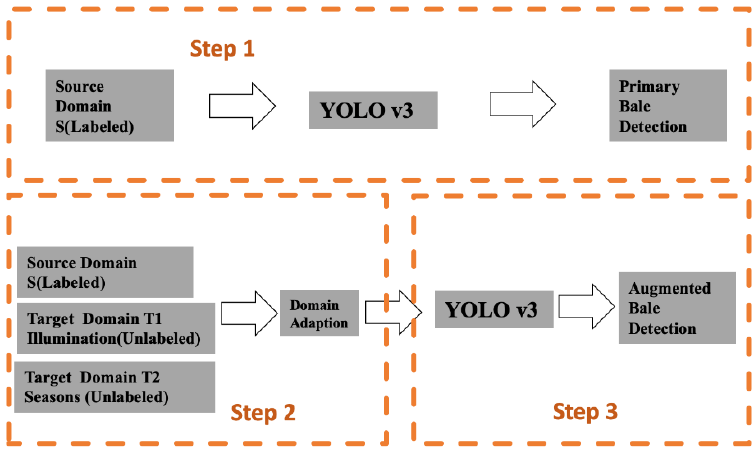
Figure 2. Framework summary of the proposed bale detection method pipeline.